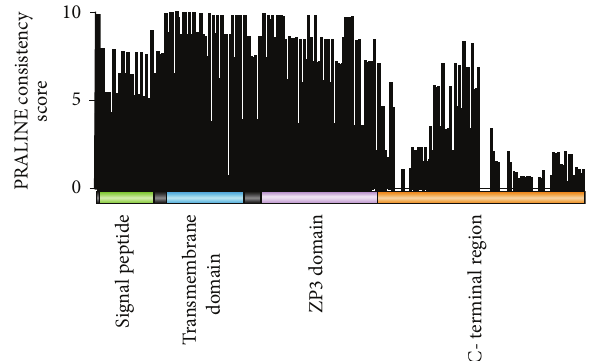
Figure 2: PLAC1 amino acid consistency scores by protein domain. A consistency score of 10 indicates no amino acid difference at the indicated position among all 25 placental mammal